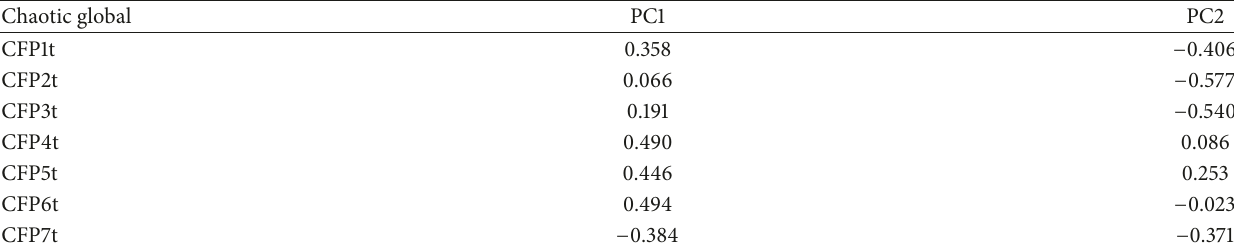
Table 3: Principal Component Analysis for CFPt for 7 groups of 31 traffic noise exposure subjects. Chaotic global PC1 PC2